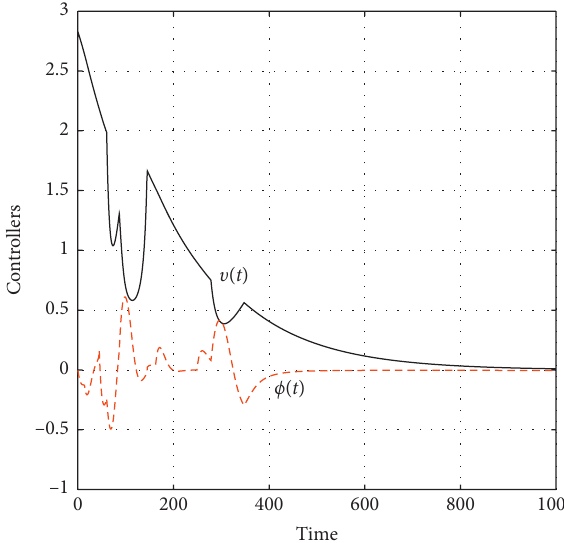
Figure 13: Evolution of controllers, v ( t ) (solid line) and ϕ ( t ) (dotted line), for the trajectory shown in Figure 11.